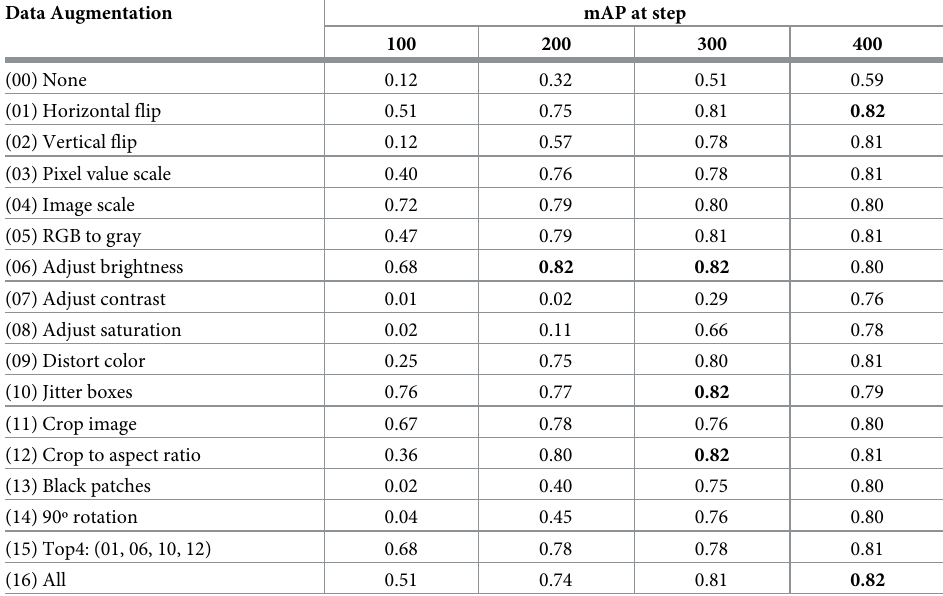
Table 10. mAP value at steps 100, 200, 300, and 400 when using various combinations of data-augmentation techniques. Data